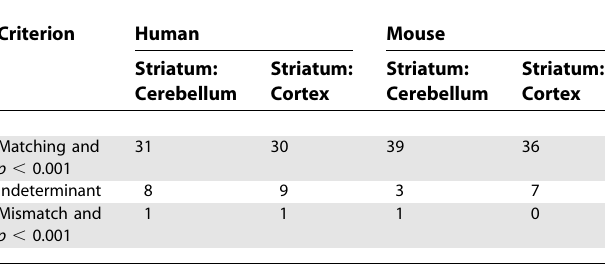
Table 2. Mouse and Human Microarray Data Are Consistent